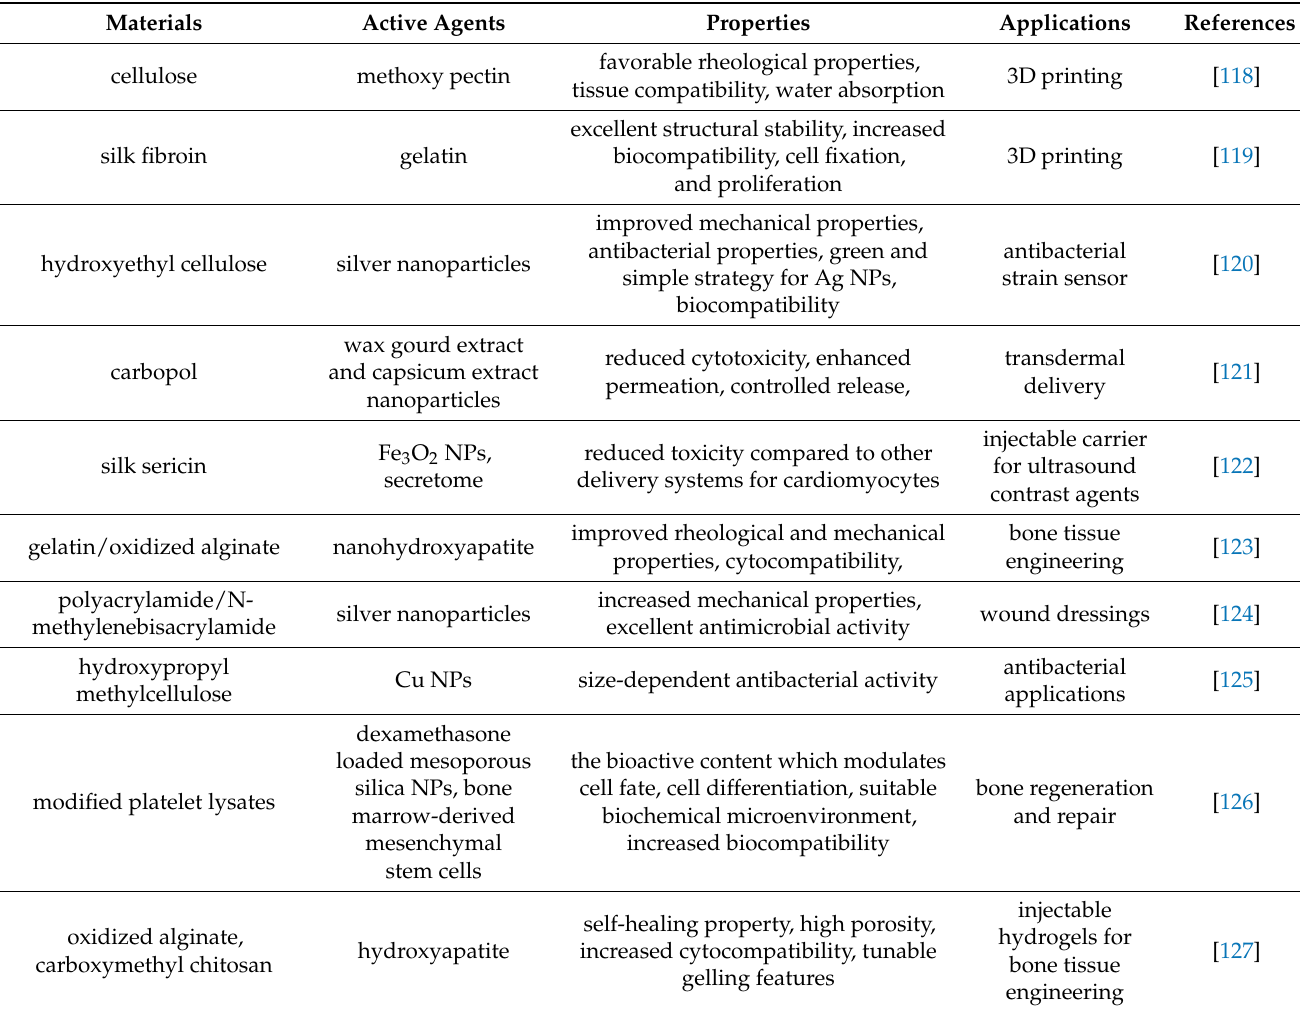
Table 2. Scaffolds based on hydrogels applied in tissue engineering and drug